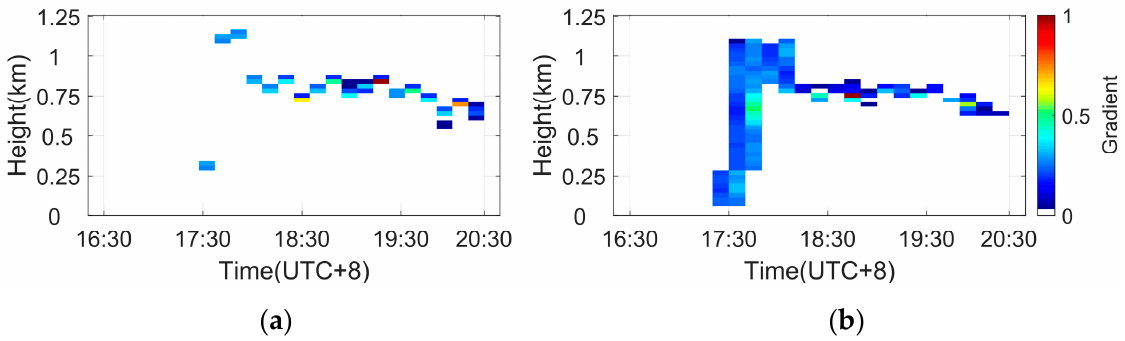
Figure 10. Using edge enhancement technology for horizontal wind speed during the sea breeze penetration on 25 September 2019. ( a ) vertical direction; ( b ) horizontal direction.